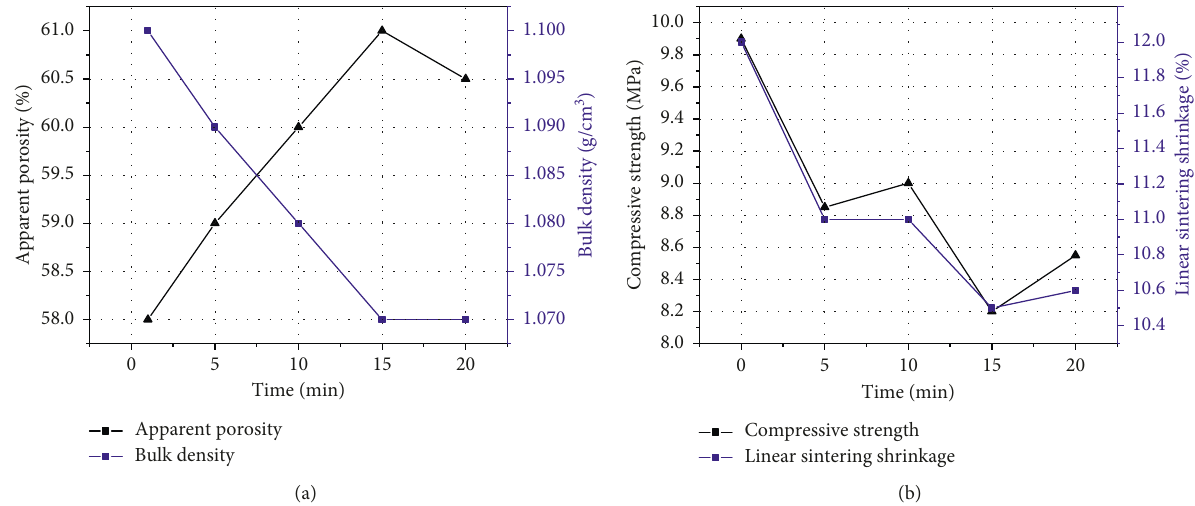
Figure 7: The influence of the holding time on (a) the apparent porosity and bulk density and (b) compressive strength and linear sintering shrinkage of as-sintered ceramics for one-stage sintering